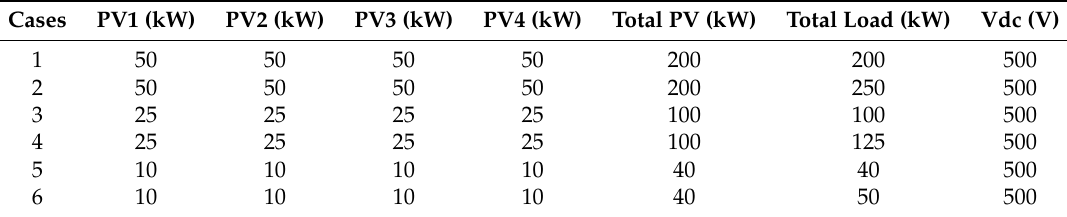
Table 4. Multi-PV operation